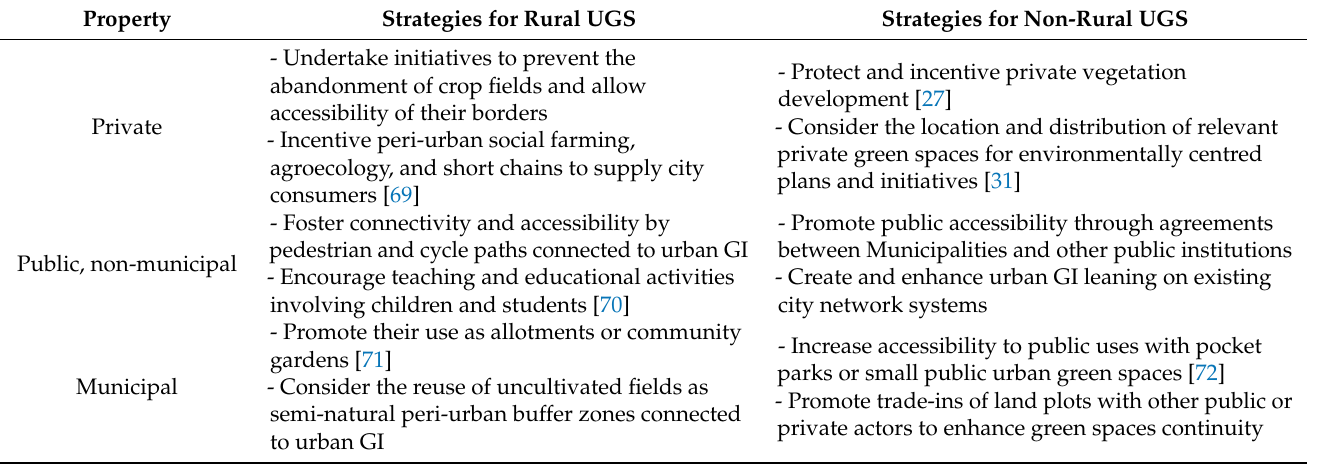
Table 12. Possible planning strategies for the UGS categories classified in the